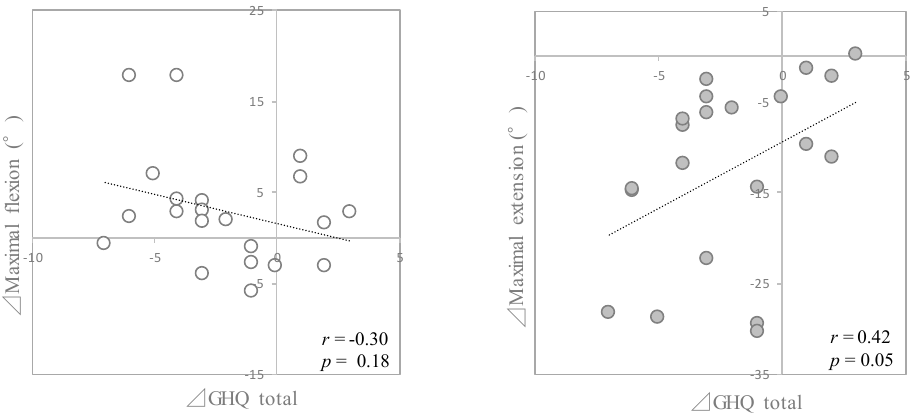
Figure 1. Correlation between the changes in the GQH total scores and